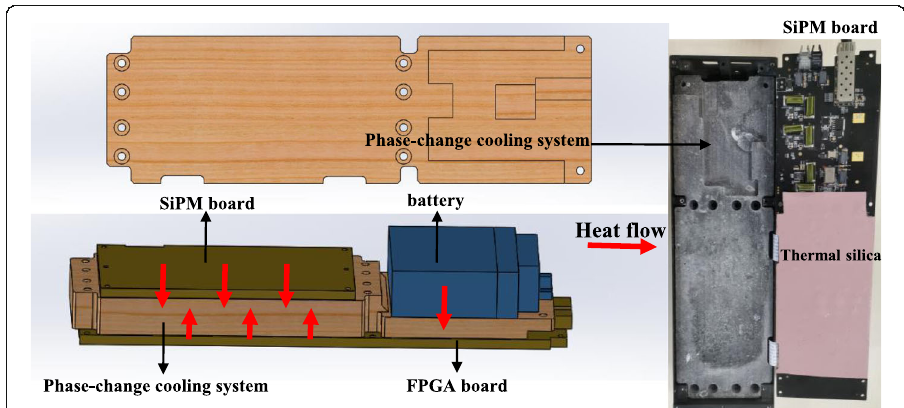
Fig. 3 Schematic of the phase-change cooling system and picture of the FPGA board with cooling